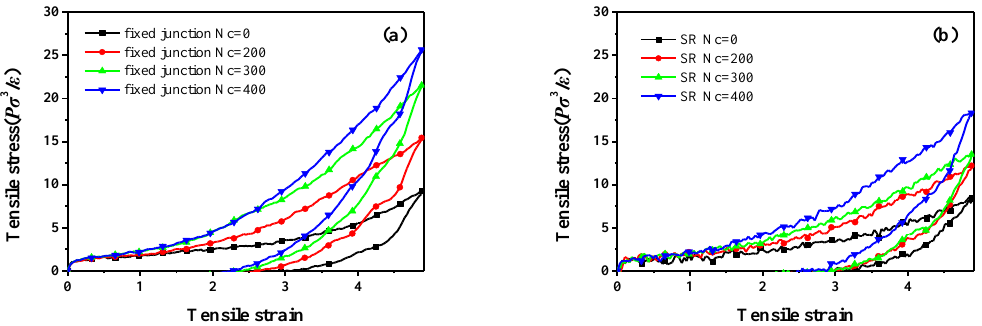
Figure 6. Stretch-recovery curves for different number of cross-linked bonds, and Nc in ( a ) the fixed junction systems and ( b ) SR systems.